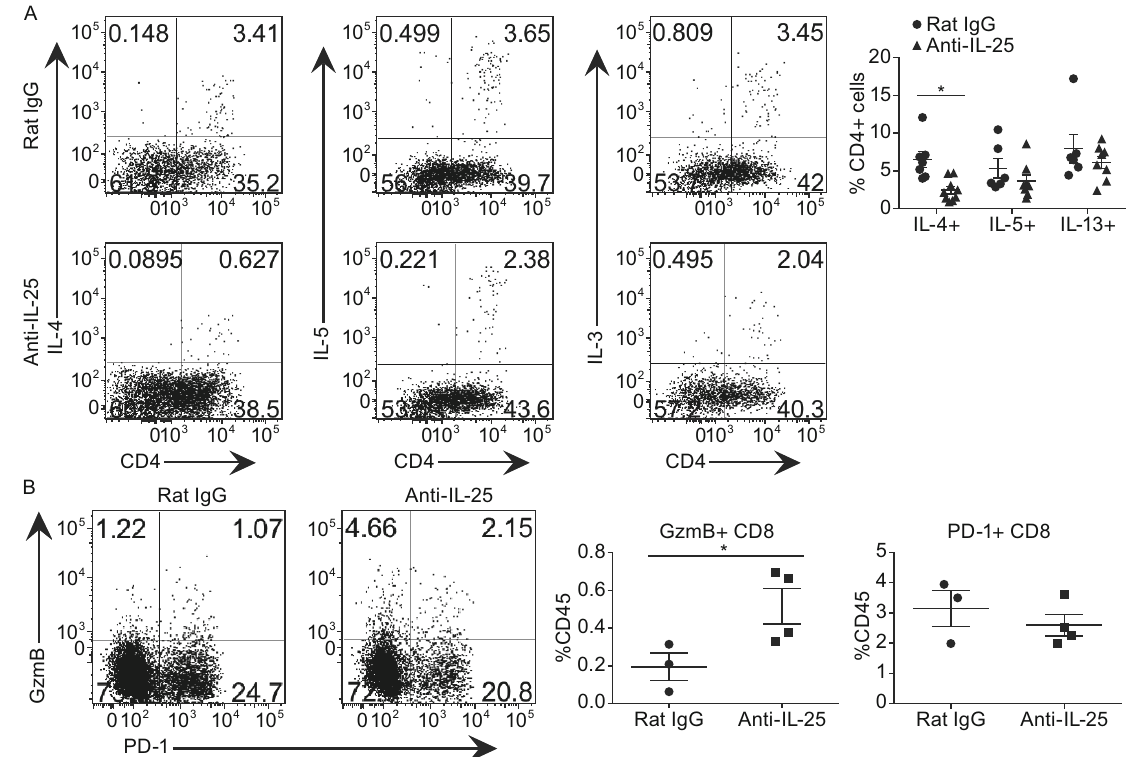
Figure 4. Anti-IL-25 antibody treatment dampened Th2-responses in the primary tumor microenvironment. The MMTV-PyMT mice were treated with either anti-IL-25 antibody or isotype control antibody starting from 4 – 5 weeks old, and sacri fi ced at 14 weeks old for the following analysis. (A) Expression of IL-4, IL-5 and IL-13 in tumor in fi ltrating cells (gated on CD4+ cells), and the statistic data were shown on the left. (B) Expression of PD-1 and Granzyme B in tumor in fi ltrating cells (gated on CD8+ cells), and the statistical data were shown on the